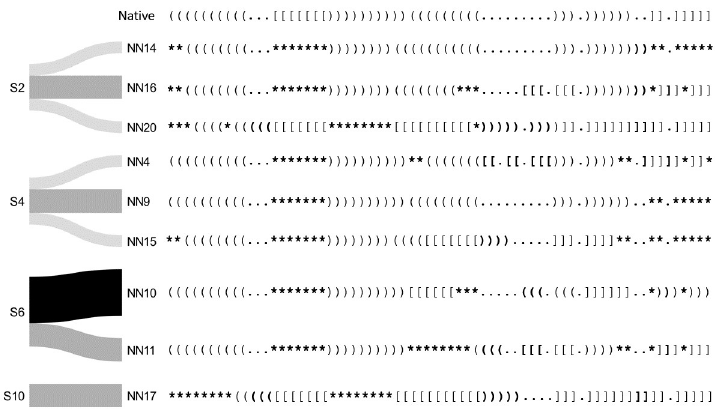
Fig 7. Shapify predicted native non-adjacent structural paths. Presentation of structural paths from the initial stems leading to native non-adjacent secondary structures. Initial stems are labeled on the left (cf. Table 4). If, for a given initial stem, the predicted structure is the same for all four SHAPE datasets, it is presented with a black colored path. In other cases, where the predicted structure is the same for three, two, or only one of the SHAPE datasets, the path is colored dark grey, grey, or light grey, respectively. Differences from native structure are marked in bold, with parentheses/brackets representing changes in paired bases, and asterisks representing predicted unpaired bases that are paired in the native